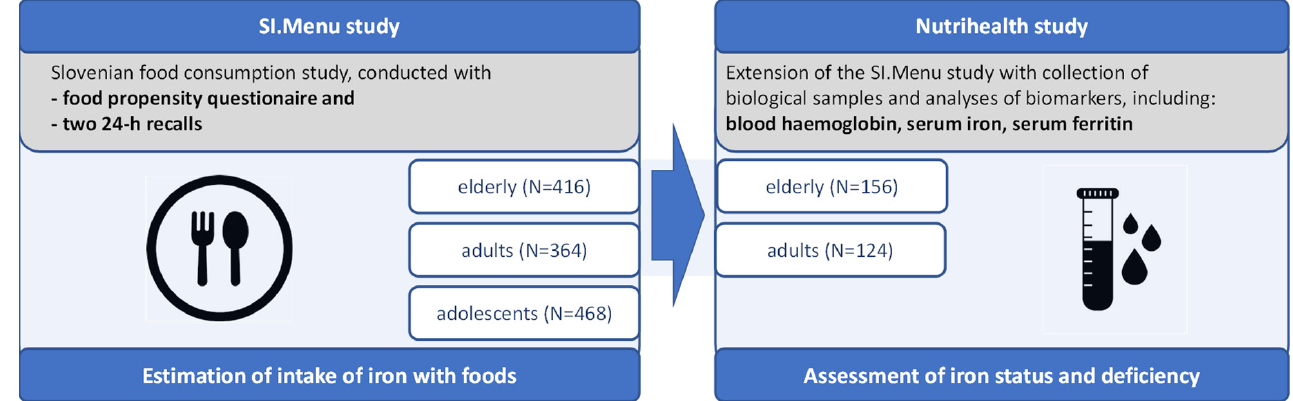
Figure 1. Schematic presentation of SI.Menu and Nutrihealth studies.